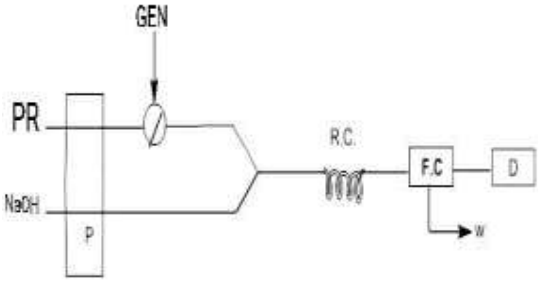
Figure 2. Schematic of FIA manifold for estimated GEN . P: peristaltic pump, F.C: Flow cell, R.C: Reaction coil and W: waste.